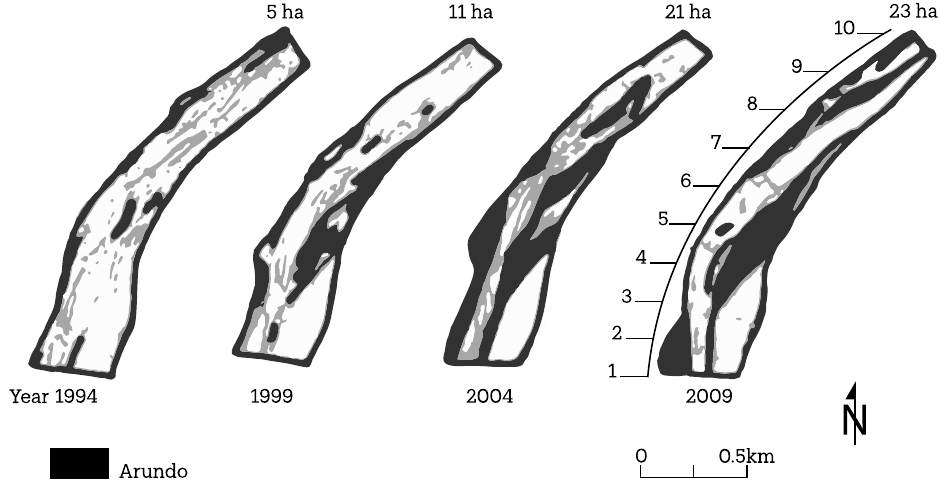
Figure 6. Maximum extent of Arundo donax (black) and native vegetation (grey) for site S2 mapped from aerial photograph years that represent the maximum amount of time since the last flood. Flow is from bottom to top. Locations of cross sections where channel characteristics were measured are shown.